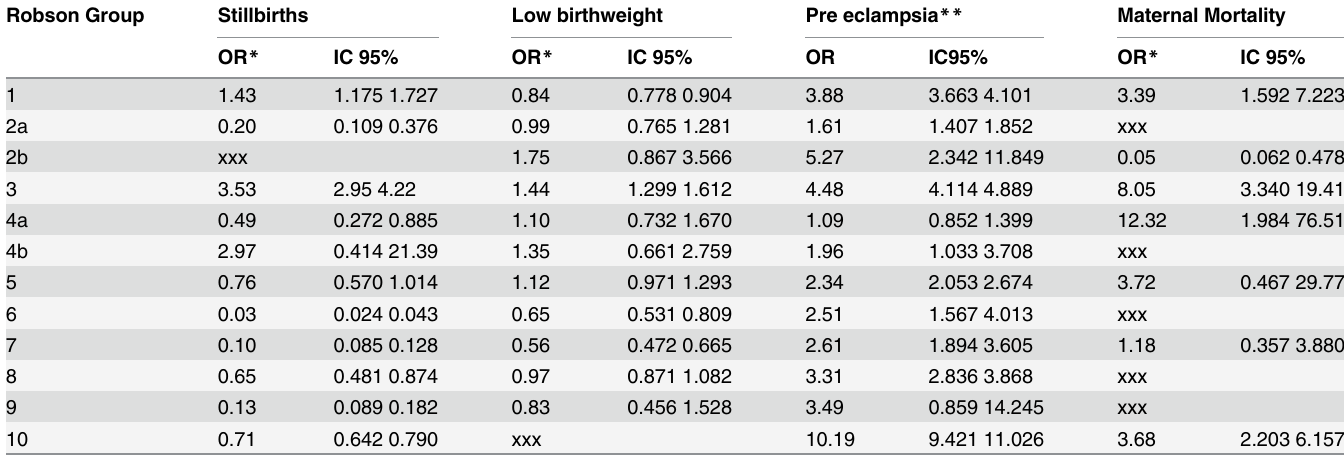
Table 6. Adjusted OR for stillbirths, low birth weight (LBW) and maternal mortality (MM) by Robson Group. Robson Group